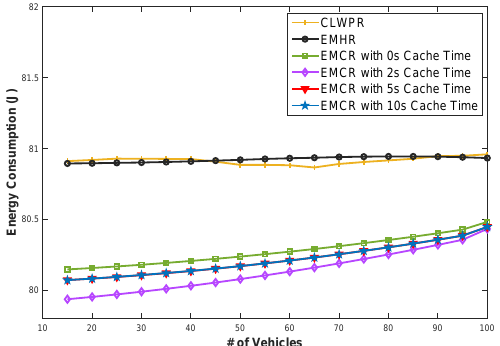
Figure 17. Energy consumption vs. Number of